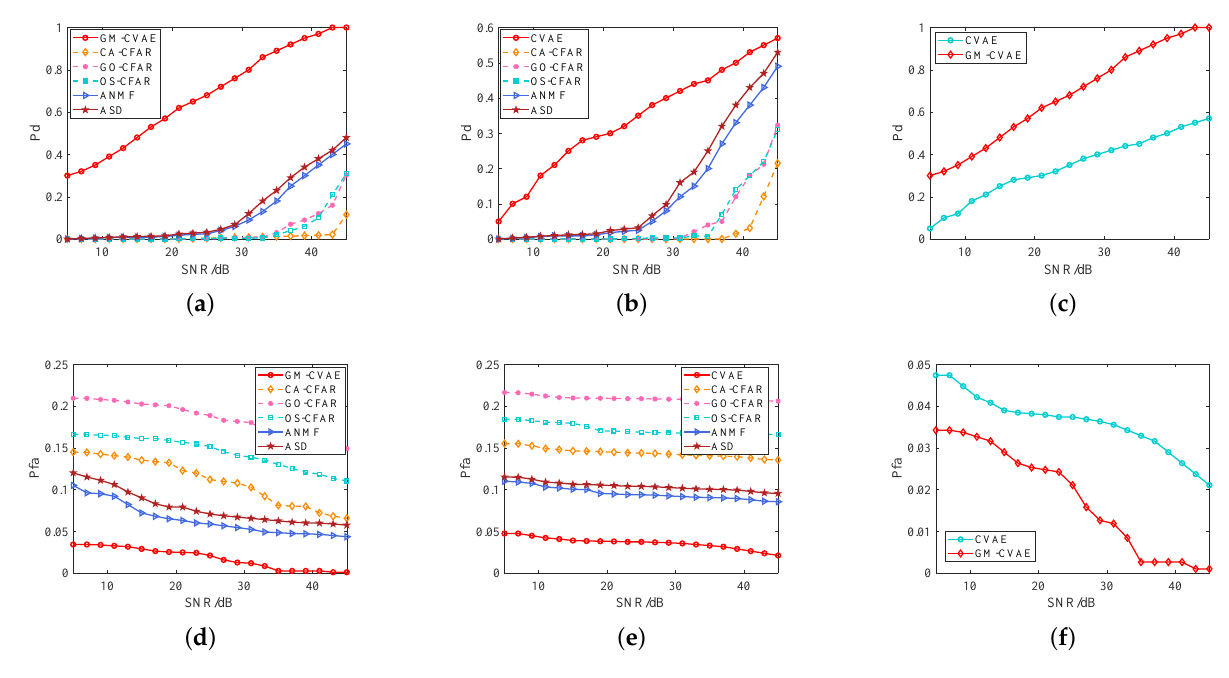
Figure 12. Complex clutter scene: ( a ) Comparison of detection probability between GM-CVAE and the five traditional detectors; ( b ) Comparison of detection probability between CVAE and the five traditional detectors; ( c ) Comparison of detection probability between GM-CVAE and CVAE; ( d ) Comparison of actual false alarm rate between GM-CVAE and the five traditional detectors; ( e ) Comparison of actual false alarm rate between CVAE and the five traditional detectors; and ( f ) Comparison of actual false alarm rate between GM-CVAE and